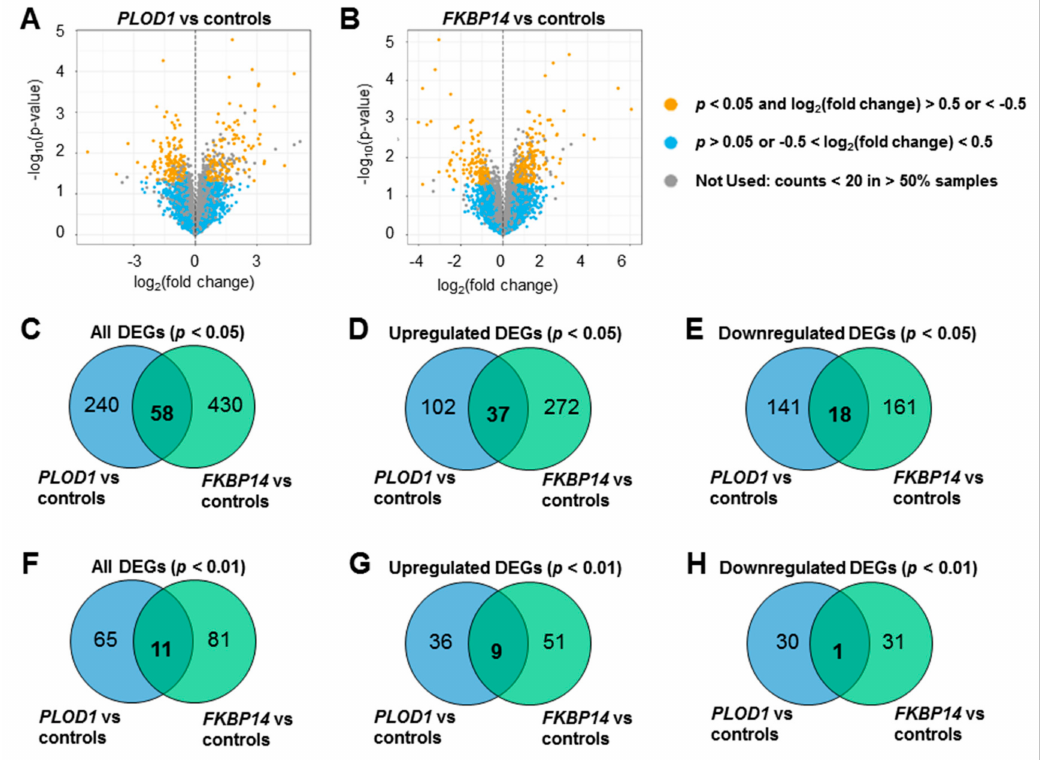
Figure 1. Transcriptome profiles of PLOD1-kEDS and FKBP14-kEDS patient-derived fibroblasts. Volcano plots of DEGs in ( A ) PLOD1 -kEDS versus controls and ( B ) FKBP14 -kEDS versus controls. ( C–E ) Venn diagrams showing number of overlapping and non-overlapping DEGs at p < 0.05 (C: all, D: up-regulated, E: down-regulated). ( F – H ) Venn diagrams showing number of overlapping and non-overlapping DEGs at p < 0.01 (F: all, G: up-regulated, H: